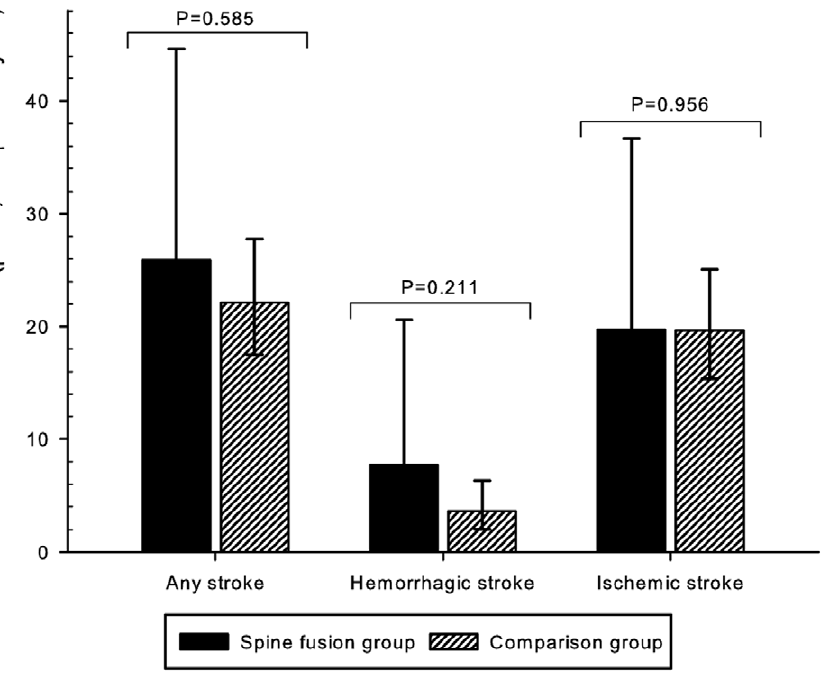
Figure 2. Comparison of stroke incidence rates. The vertebroplasty group had similar incidence rates of any, hemorrhagic and ischemic strokes to that of the comparison group.